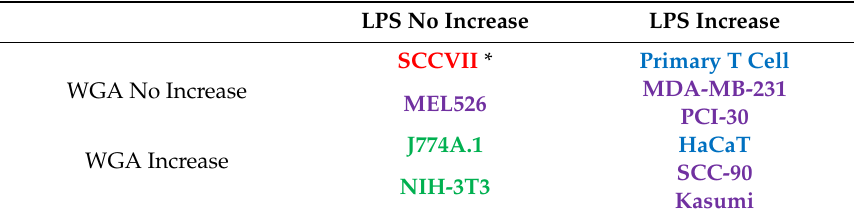
Table 4. Correlations among responses to WGA and LPS effects on brain uptake as a function of cell species and cancerous/noncancerous states.